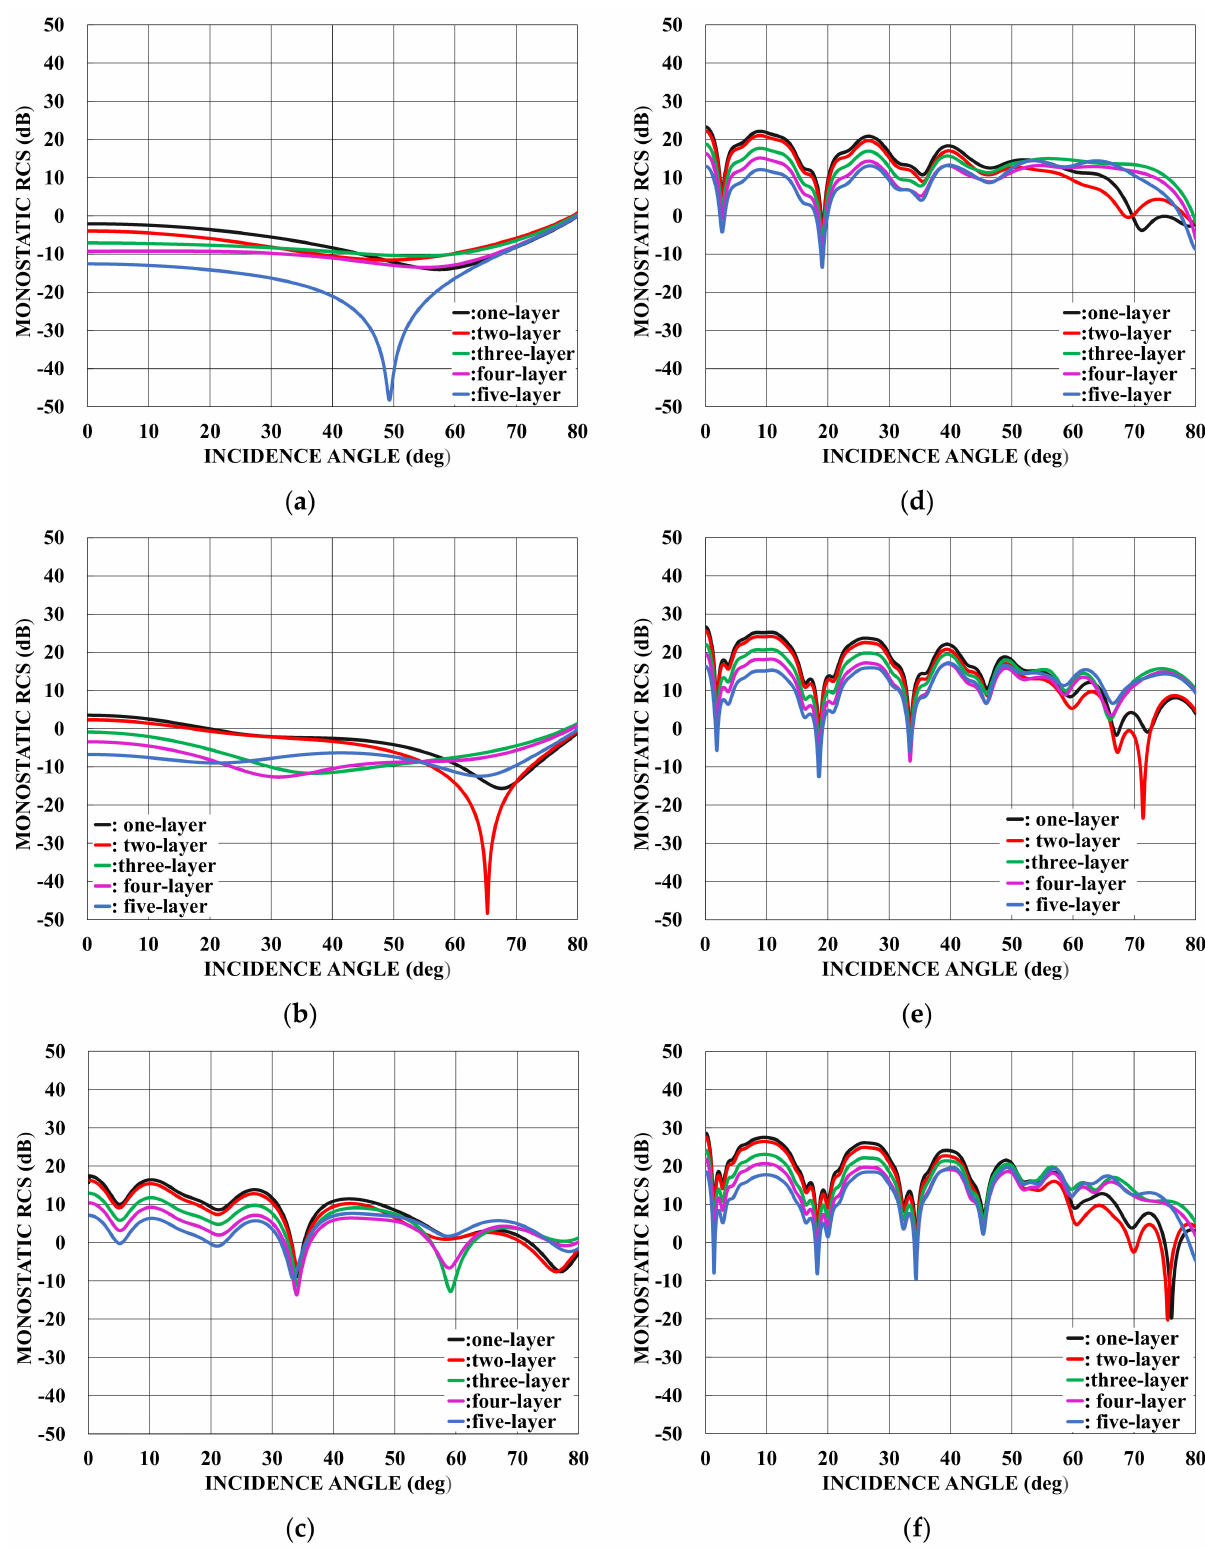
Figure 4. Monostatic RCS [dB] versus incidence angle θ 0 for L 1 /2 b = 3.0, kt = 1.57. Other particulars are the same as in Figure 2. ( a ) kb = 1.57. ( b ) kb = 3.14. ( c ) kb = 15.7. ( d ) kb = 31.4. ( e ) kb = 47.1. ( f ) kb =